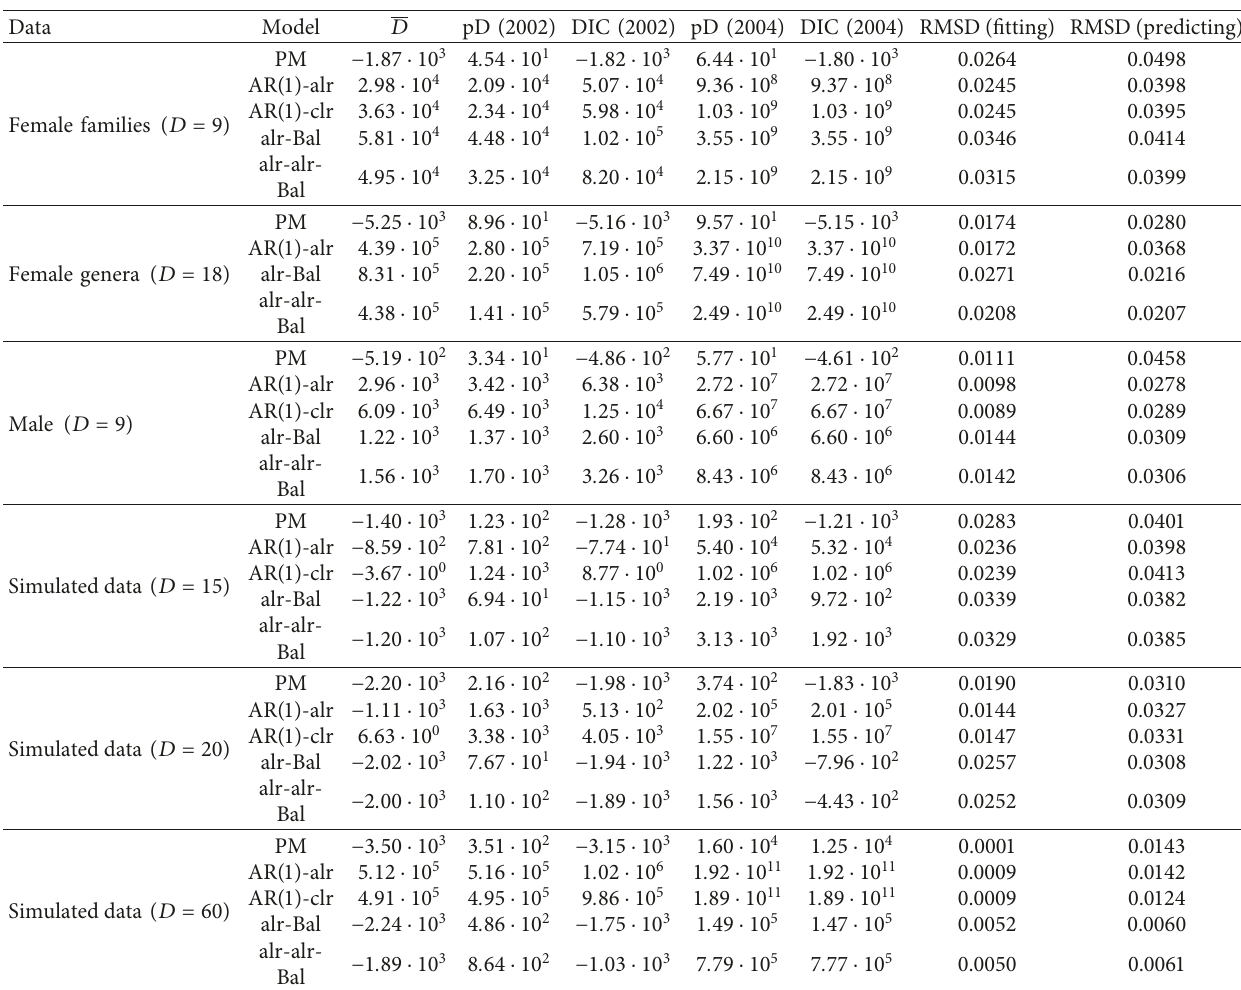
Table 5: Deviance information criterion (DIC) defined in [63] and the DIC defined in [64]. The root mean square deviation (RMSD) of the results obtained fitting the model and the RMSD of the results obtained using the model for